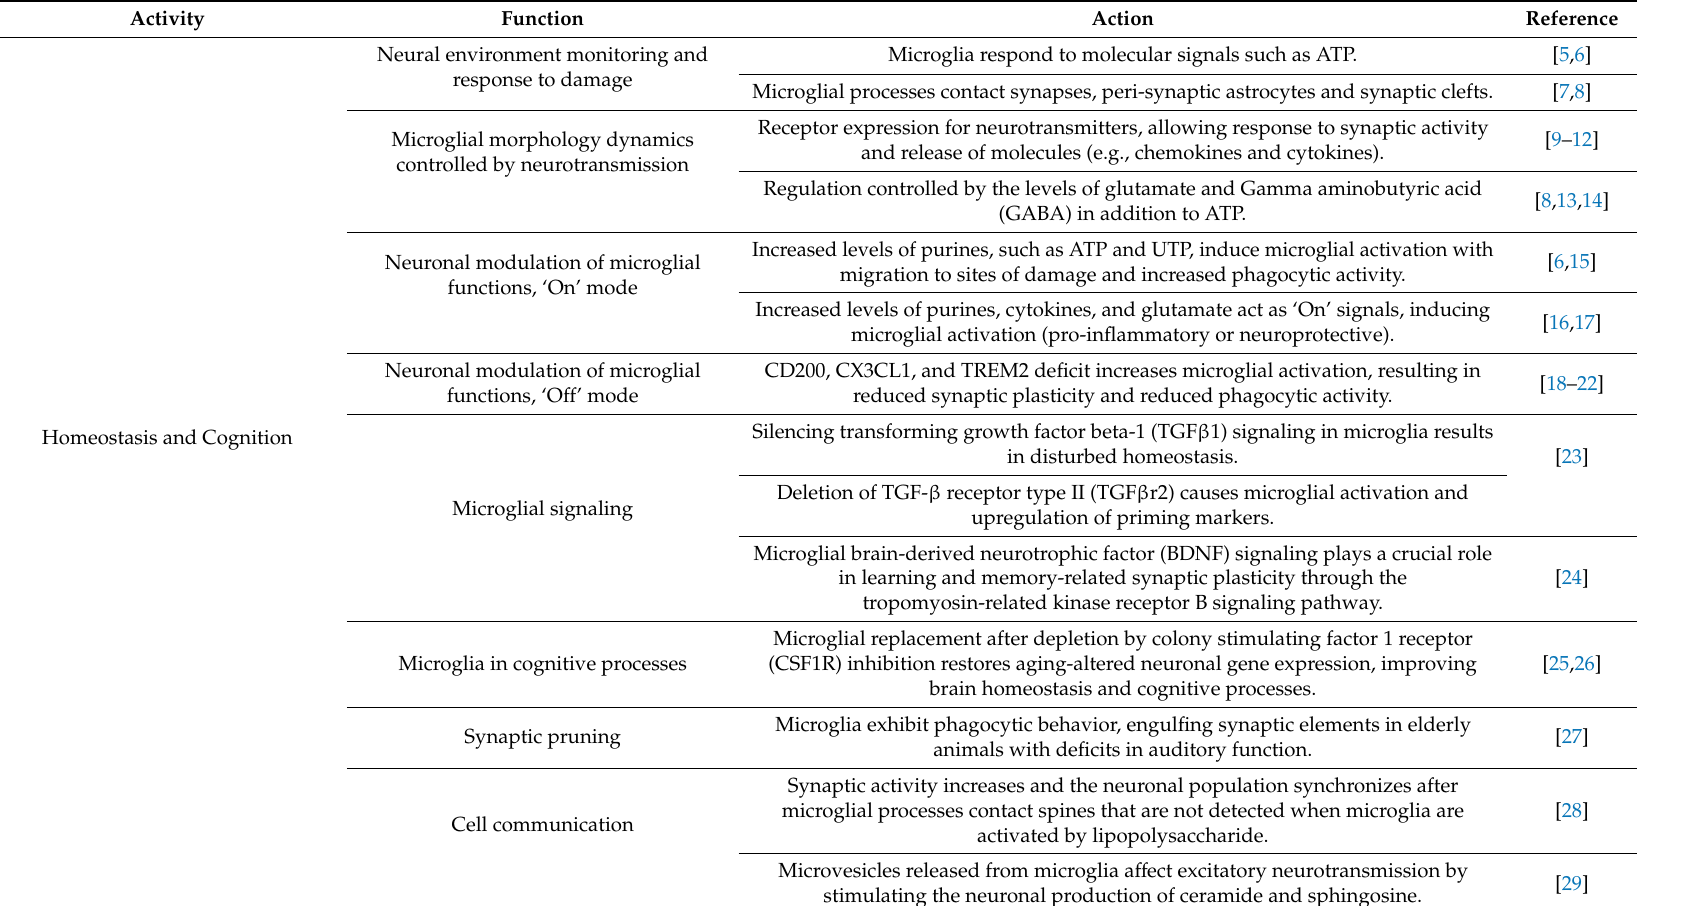
Table 1. Overview of the evidence accumulated on the roles of microglia in the healthy adult